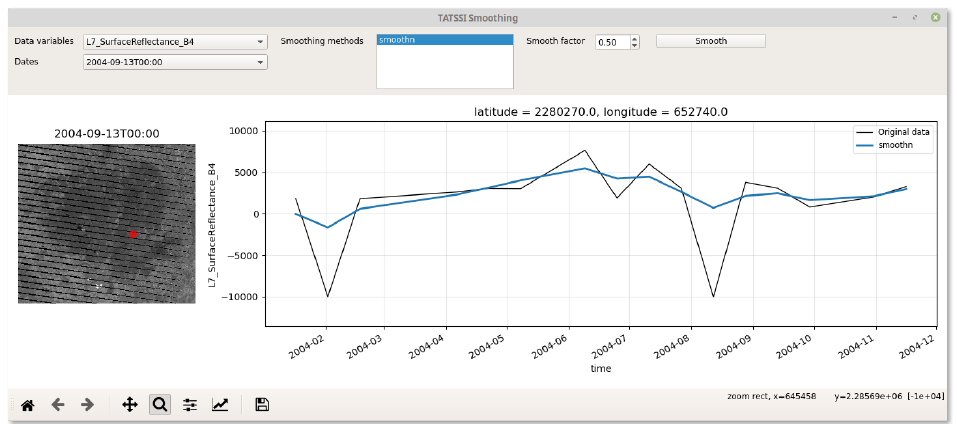
Figure 5. TATSSI GUI Smoothing showing an annual time series of Landsat 7 near-infrared (NIR) surface reflectance during 2004. The time series was not generated using TATSSI, but the required metadata were added to allow its ingestion into